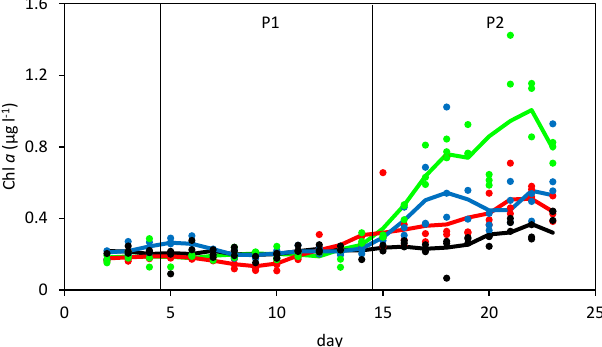
Figure 2. Temporal evolution of chlorophyll a (Chl a ) concentra- tions (µgL − 1 ) in the mesocosms and surrounding waters. The color code is identical to that in Fig. 1. The three dots of each color rep- resent the measured values at the three sampled depths. The solid lines are the 3-day running mean value. P1 and P2 denote the two phases of the experiment when the diazotrophic community was dominated by diatom–diazotroph associations and unicellular N 2 - fixing cyanobacteria (group C),